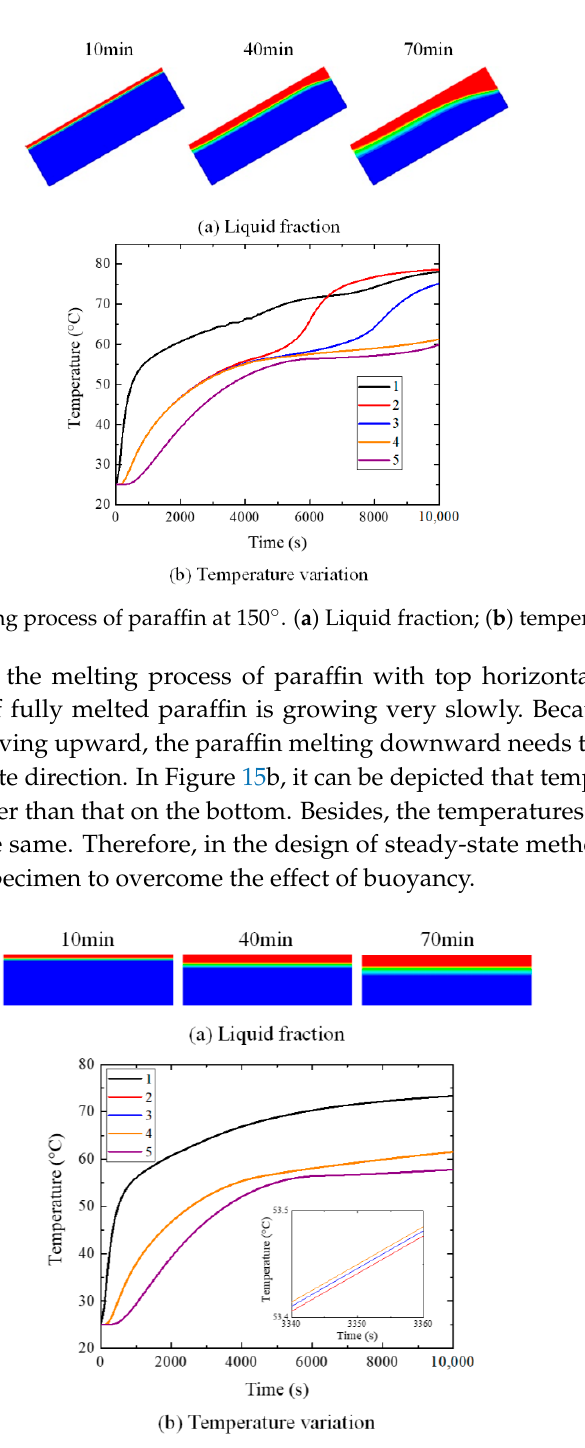
Figure 13. The melting process of paraffin at 120°. ( a ) Liquid fraction; ( b ) temperature variation.